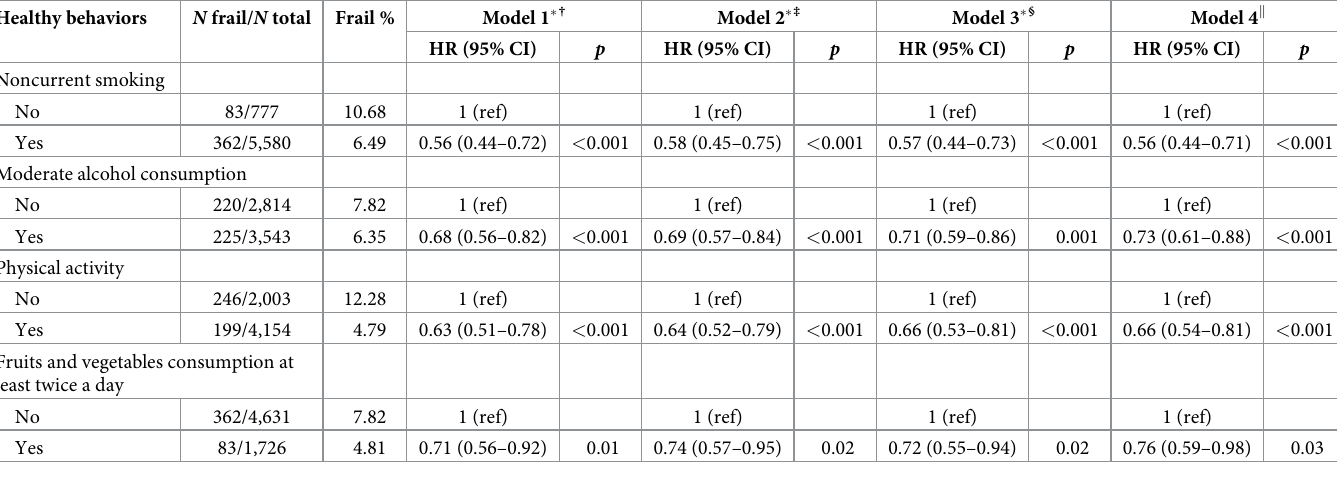
Table 3. Association between healthy behaviors at age 50 in 2 categories and onset of frailty over a mean follow-up of 20 years. Healthy behaviors N frail/ N total Frail